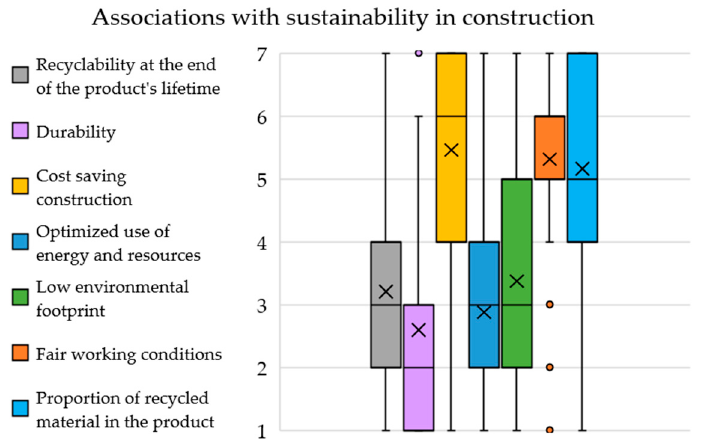
Figure 5. Respondents’ associations with sustainability in construction with 1 = maximum and 7 = minimum.